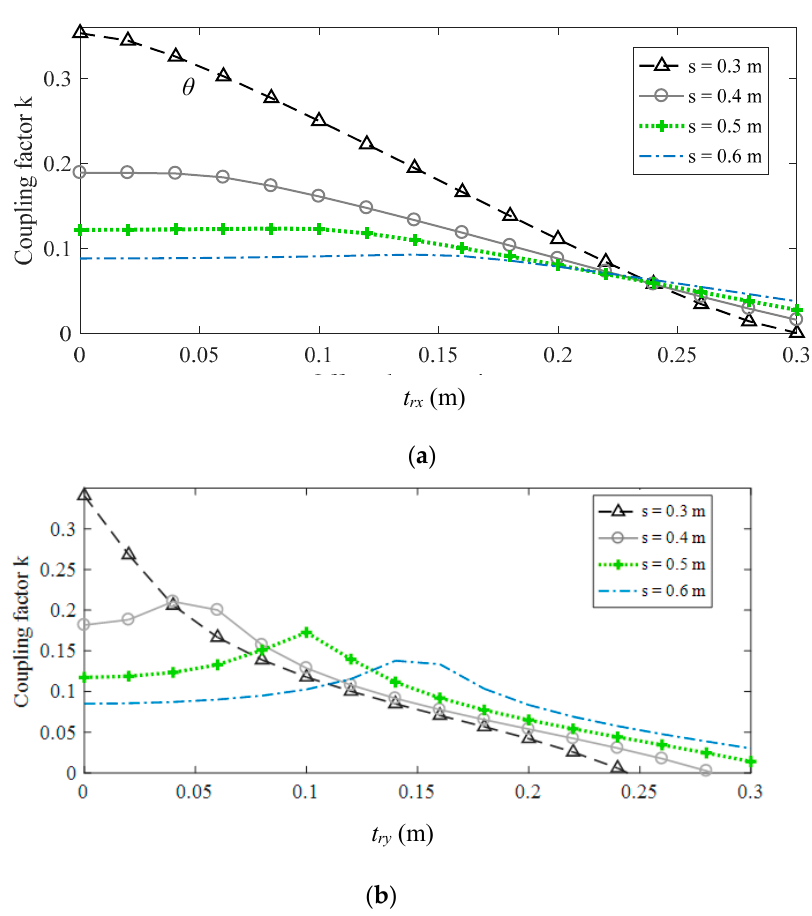
Figure 5. Coupling factor k vs. lateral misalignments t rr ( a ) and t ry ( b ) for variable side length s of the transmitting coil.